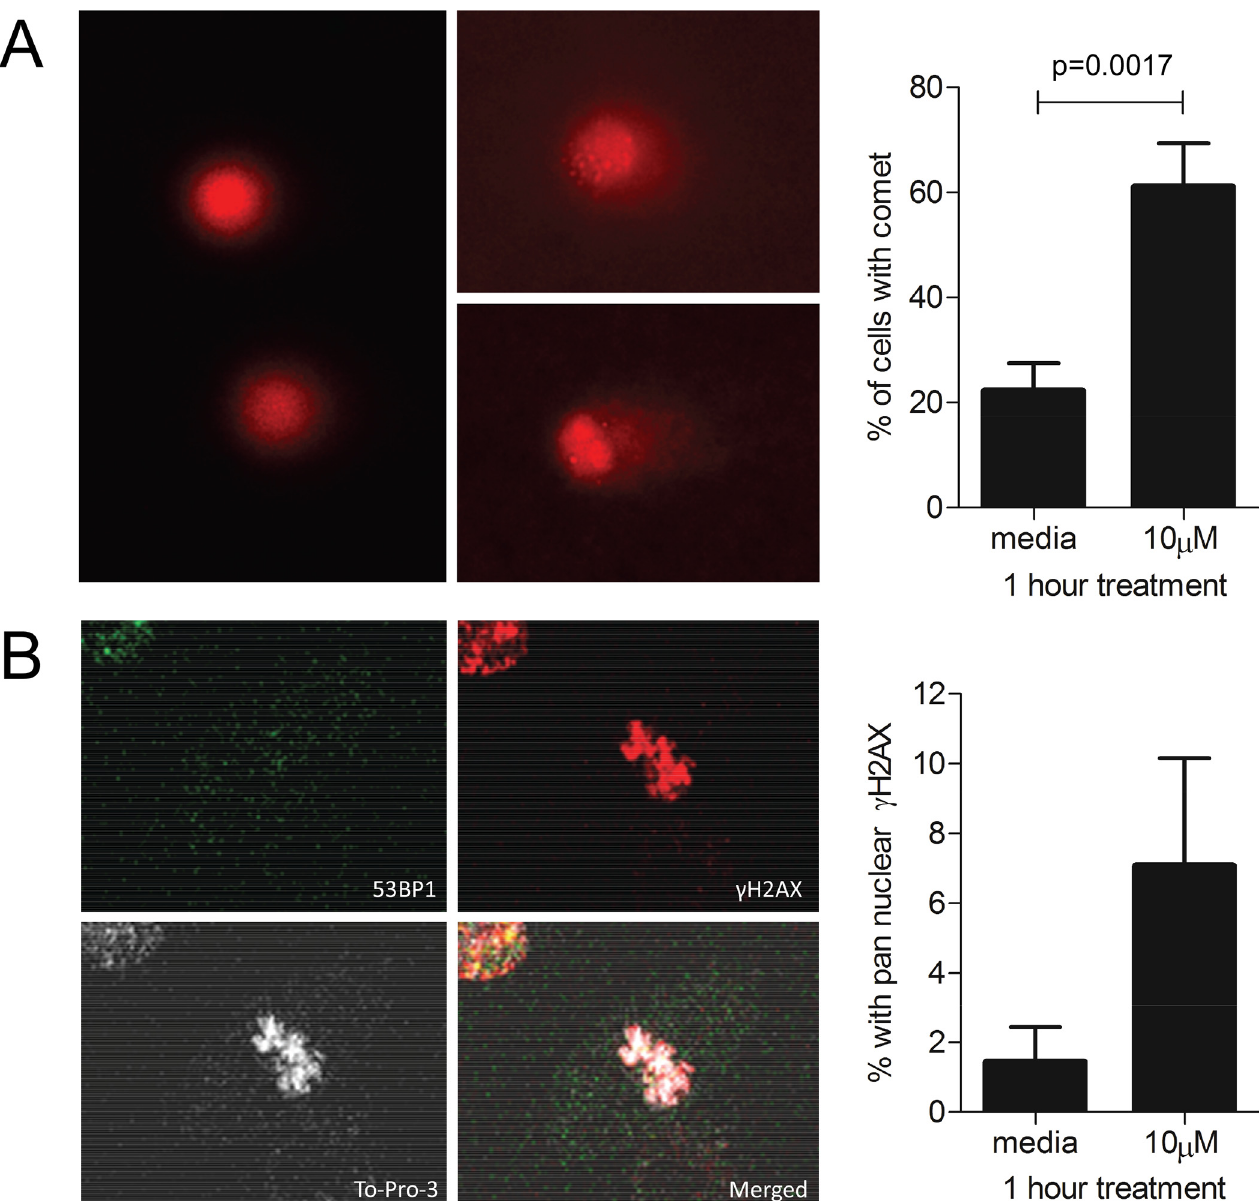
Fig 7. DNA damage and cell death following iron treatments. A) Morphological appearance and quantification of comet tails in propidium-iodide stained HUVEC after treatment for 1 hour with fresh media or iron (II) citrate. Left: HUVEC without the comet phenotype. Centre: HUVEC with typical comet tails- note that in these alkaline experimental conditions, comets could result from single or double stranded breaks, abasic sites and/or other sites where DNA repair was taking place. Right: The proportion of HUVEC with comets after 1 hour treatment with media or 10 μ M iron (II) citrate. Mean and SEM displayed, p value calculated by Mann Whitney ( original images supplied). B) Morphological appearances of pan-nuclear γ H2AX staining in HUVEC treated with 10 μ M iron (II) citrate for 1 hour. This pattern, if UV-induced, precedes and parallels UV-induced S phase apoptosis, and is considered a marker of dying cells. [46] TOPRO- 3 (white) and 53BP1 (green) counterstain nucleus and cytoplasm respectively; a second cell is observed in the top left corner. (Original images supplied.) Right: quantification of pan-nuclear γ H2AX staining in HUVEC treated with media or 10 μ M iron (II) citrate for 1 hour. Mean and SEM displayed, p value calculated by Mann